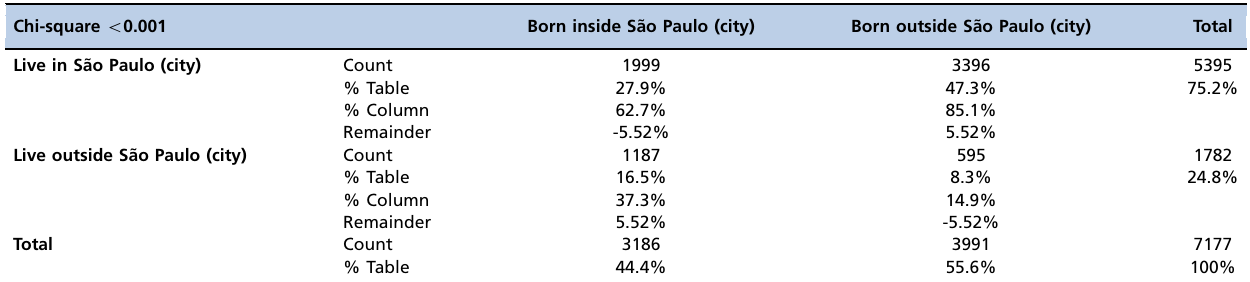
Figure 2 - Kernel maps showing the geographic distribution of physicians who graduated from FMUSP. Table 4 - Analysis of professionals who were born in Sa˜o Paulo (city) versus those who are born outside Sa˜o Paulo (city). Chi-square o